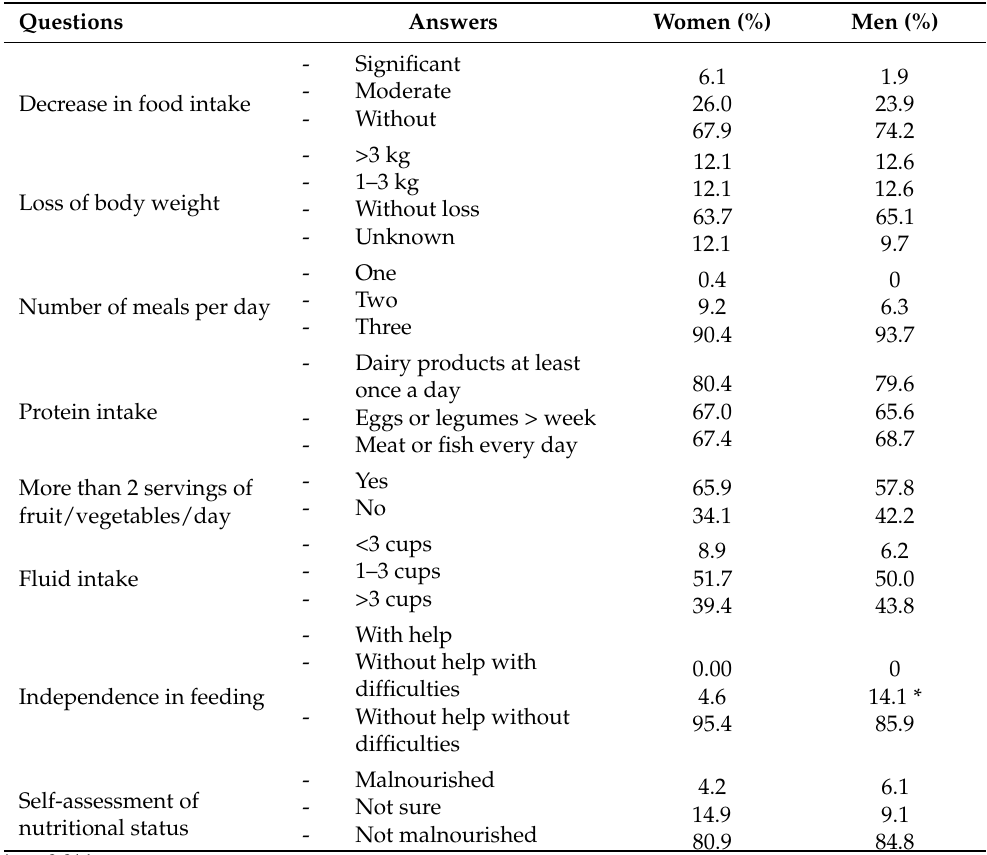
Table 3. Characteristics of food intake in participants based on Mini Nutritional Assessment (MNA)